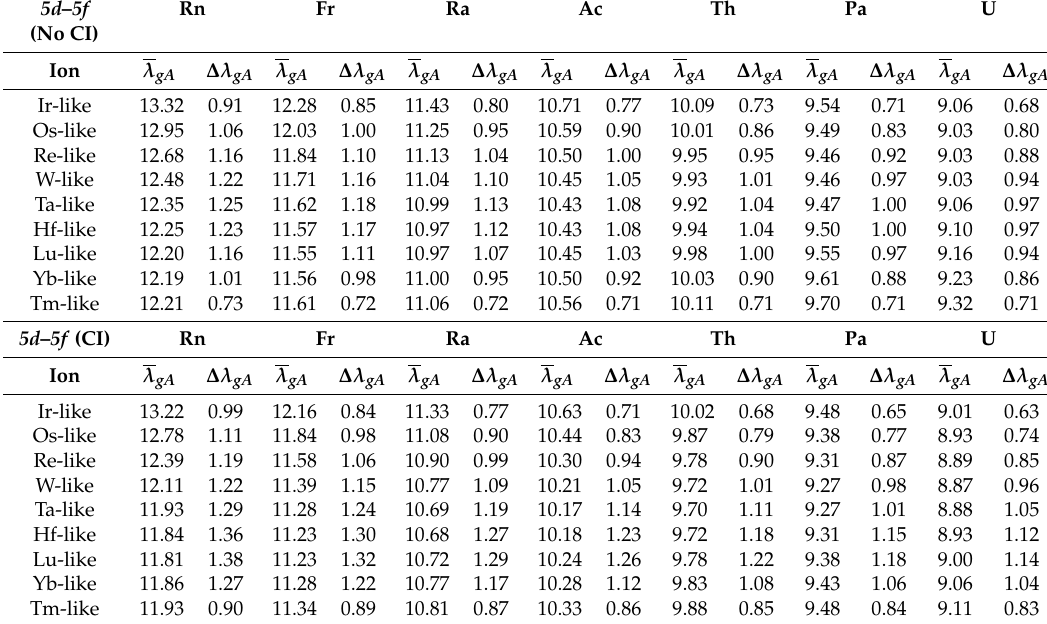
Table 2. Calculated mean wavelength λ gA (nm) and spectral width ∆ λ gA (nm) for the UTA of radon through uranium ions: Ir-like to Tm-like ions for the 5d – 5f arrays without and with the effect of configuration